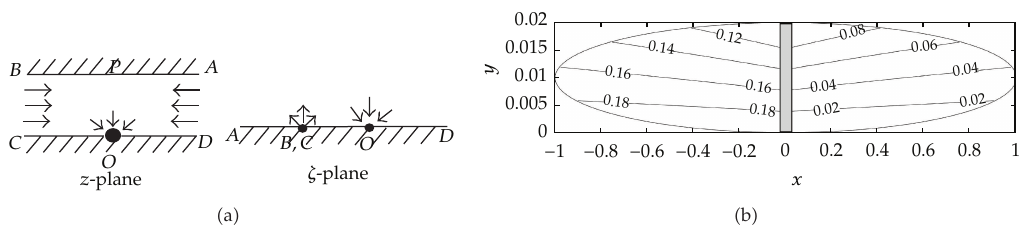
Figure 5: (cid:5) a (cid:6) Plot of the local flow problem in both the z -plane and the ζ -plane. (cid:5) b (cid:6) Contours of the streamfunction (cid:5) b (cid:6) Ψ ≈ Ψ 0 at time t (cid:9) 0 with initial conditions a (cid:9) 1 , b (cid:9) 1 / 100. The streamlines are all directed towards the centre x (cid:9) 0. Concerning the shaded area in the middle, see Figure 6 for the solution closer to x (cid:9) 0.